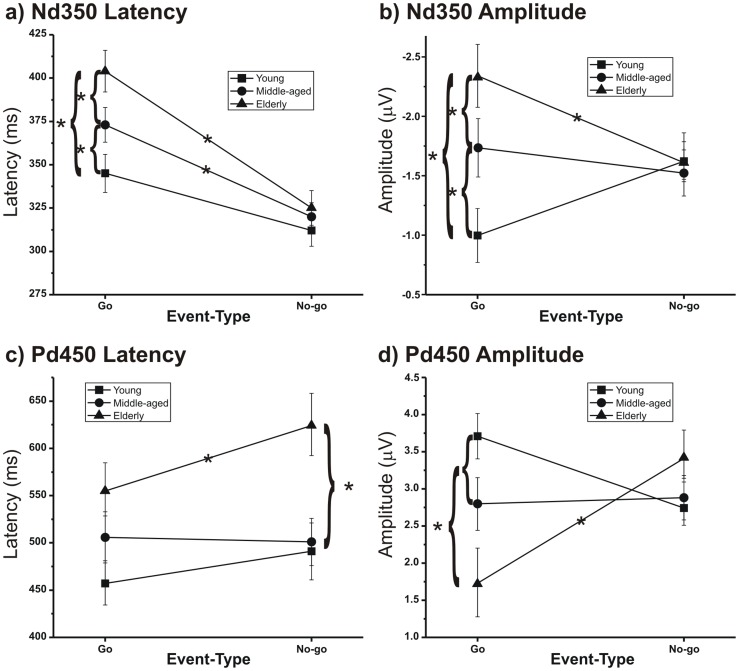
The significant interactions between the Groups and Event-Types for the Nd350 (top) and the Pd450 (bottom).See Fig. 3 for details.